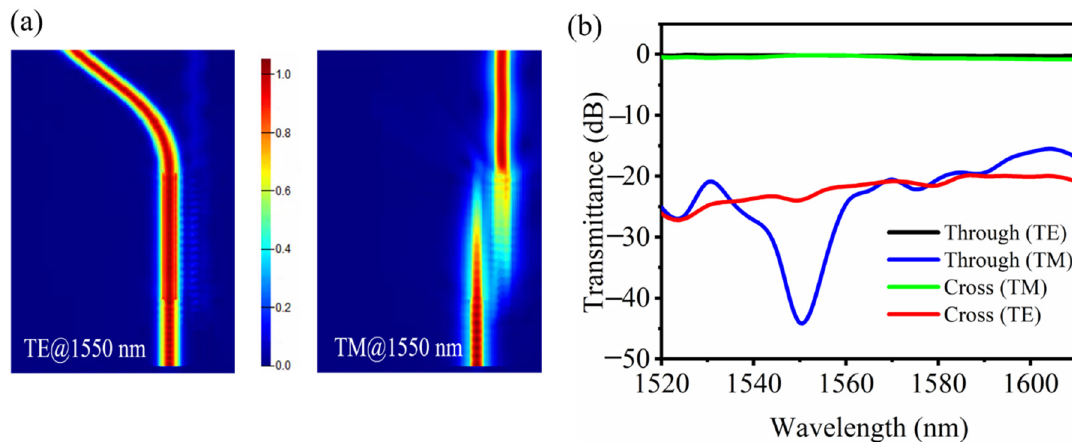
Figure 5. ( a ) Simulated light propagation and ( b ) transmission spectra of the PBS device for both polarizations.